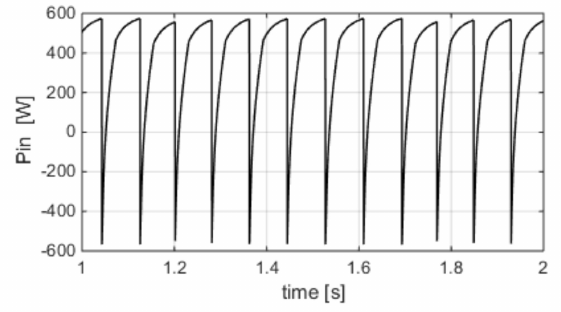
Figure 13. The waveform of input power (P in